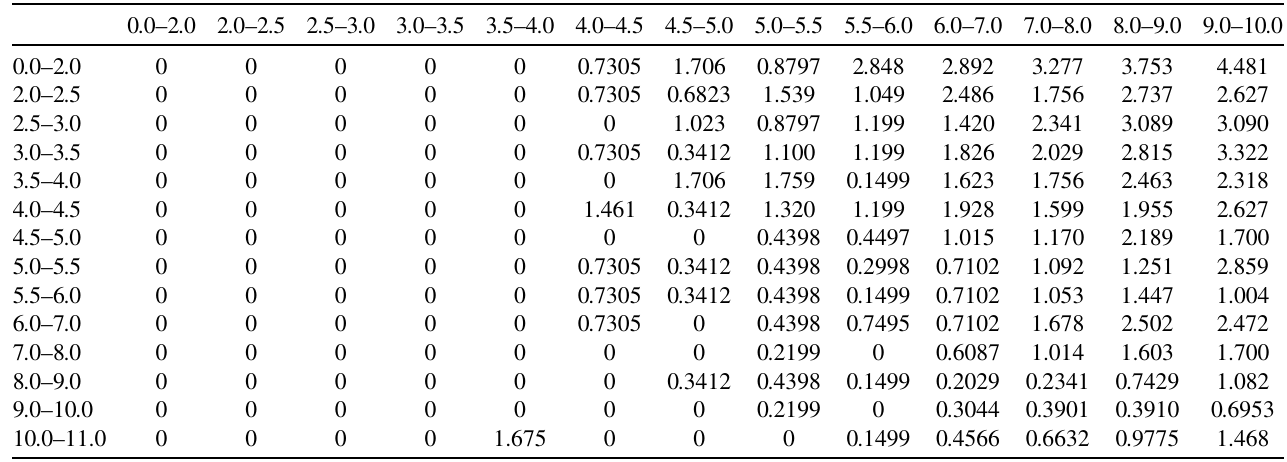
TABLE XI. (cid:4) þ background from (cid:3) (cid:5) CC events (all values (cid:2) 10 (cid:1) 4 ).